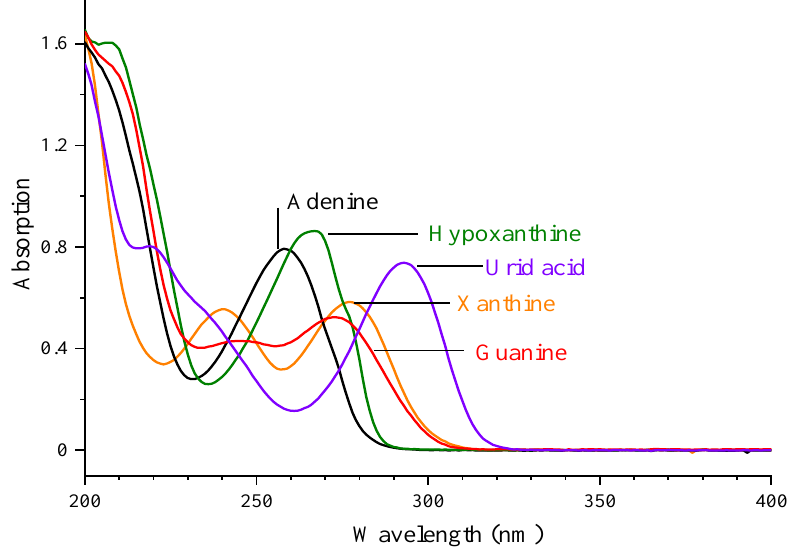
Figure 2. UV full wavelength scan of purine bases and uric acid.